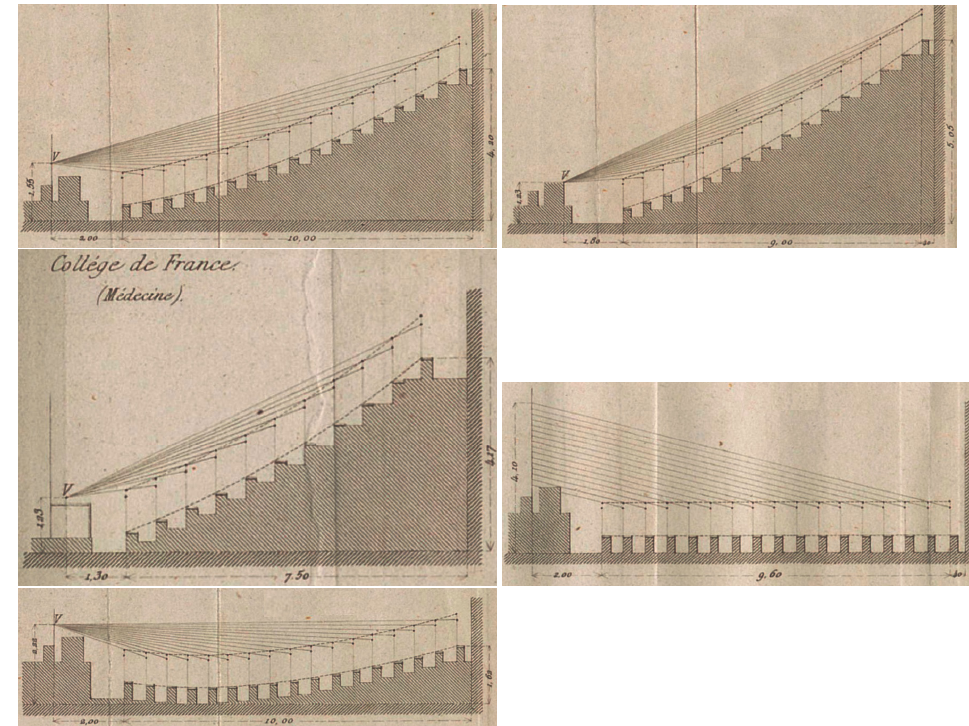
Figure 2. Various audience rake studies according to Lachèz [17] and sight-/sound-lines which abide by the courbe audio-visuel . Images courtesy of the Bibliothèque nationale de